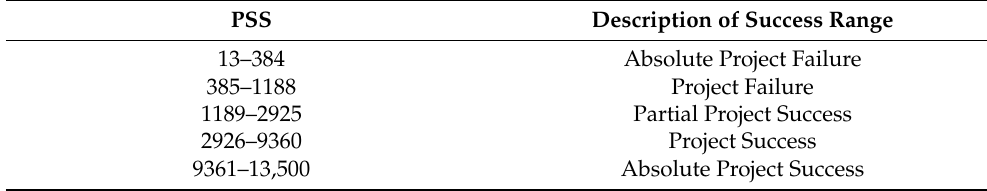
Table 3. Conversion of PSS to Range Bands.